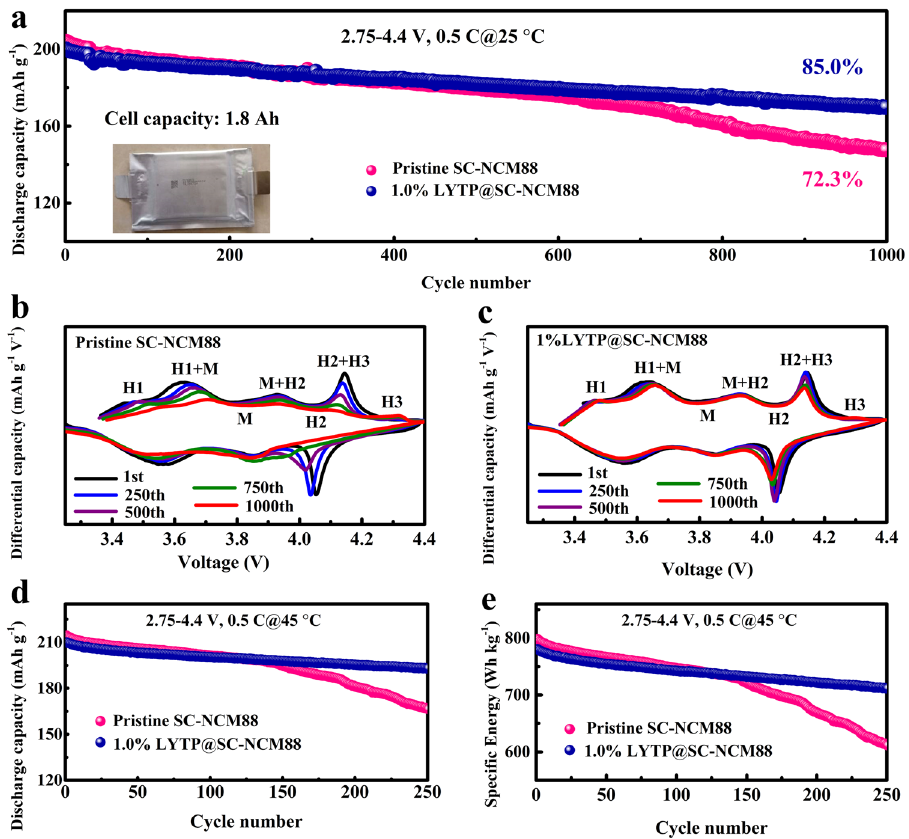
Fig. 5 Electrochemical evaluation for pouch-type full cells. a Cycling performances and ( b , c ) corresponding dQ/dV curves of the pristine SC-NCM88 and the 1% LYTP@SC-NCM88 against a graphite anode from the 1st cycle to the 1000th cycle. d Cycling performance and ( e ) speci fi c energy for the pristine SC-NCM88 and the 1% LYTP@SC-NCM88 at an elevated temperature of 45 °C. All cells were cycled in the voltage range of 2.75 – 4.4